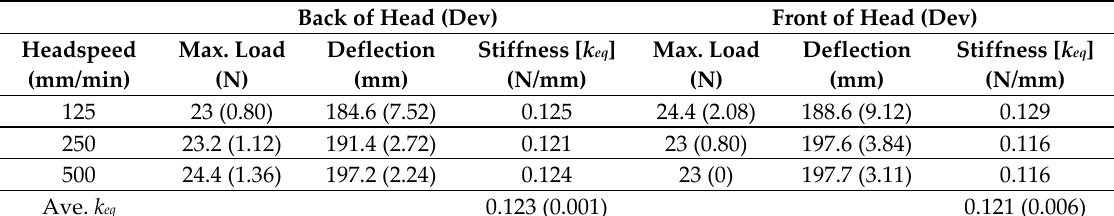
Table 1. Example test data for determining stiffness from the quasi-static load test. Back of Head (Dev) Front of Head (Dev)